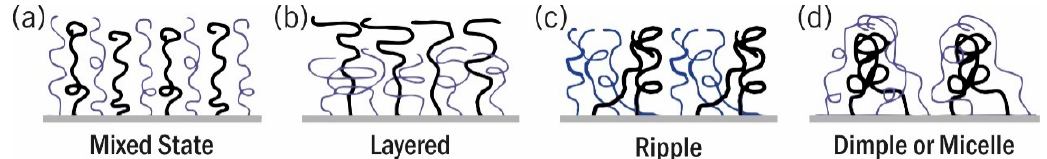
Figure 3. Schematics illustration of nanostructures: ( a ) mixed state, ( b ) layered, ( c ) ripple, ( d ) dimple (with periodic long-range order) or micelle (without periodic long-range order). (Reproduced with permission from Reference [55], Copyright 2009, American Chemical Society).